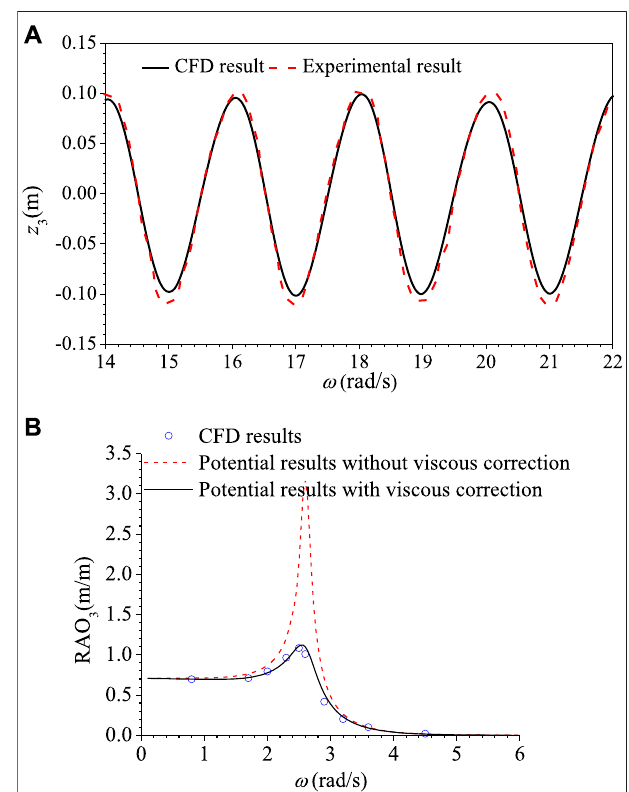
Figure 1 | Comparison of heave motion between the CFD results with other results. (A) Comparison of the heave motion between the present CFD result and the experiment result (Shi et al., 2019). (B) Comparison of RAO in the heave mode between the CFD results and the PFT results with and without viscous